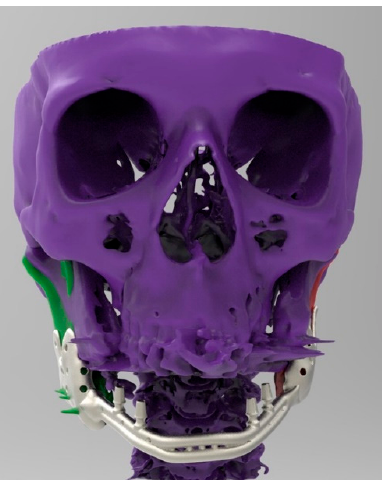
Figure 5. Lateral view of the mandibular body that was shaped and connected to the residual mandibular branches. Int. J. Environ. Res. Public Health 2020 , 17 , x